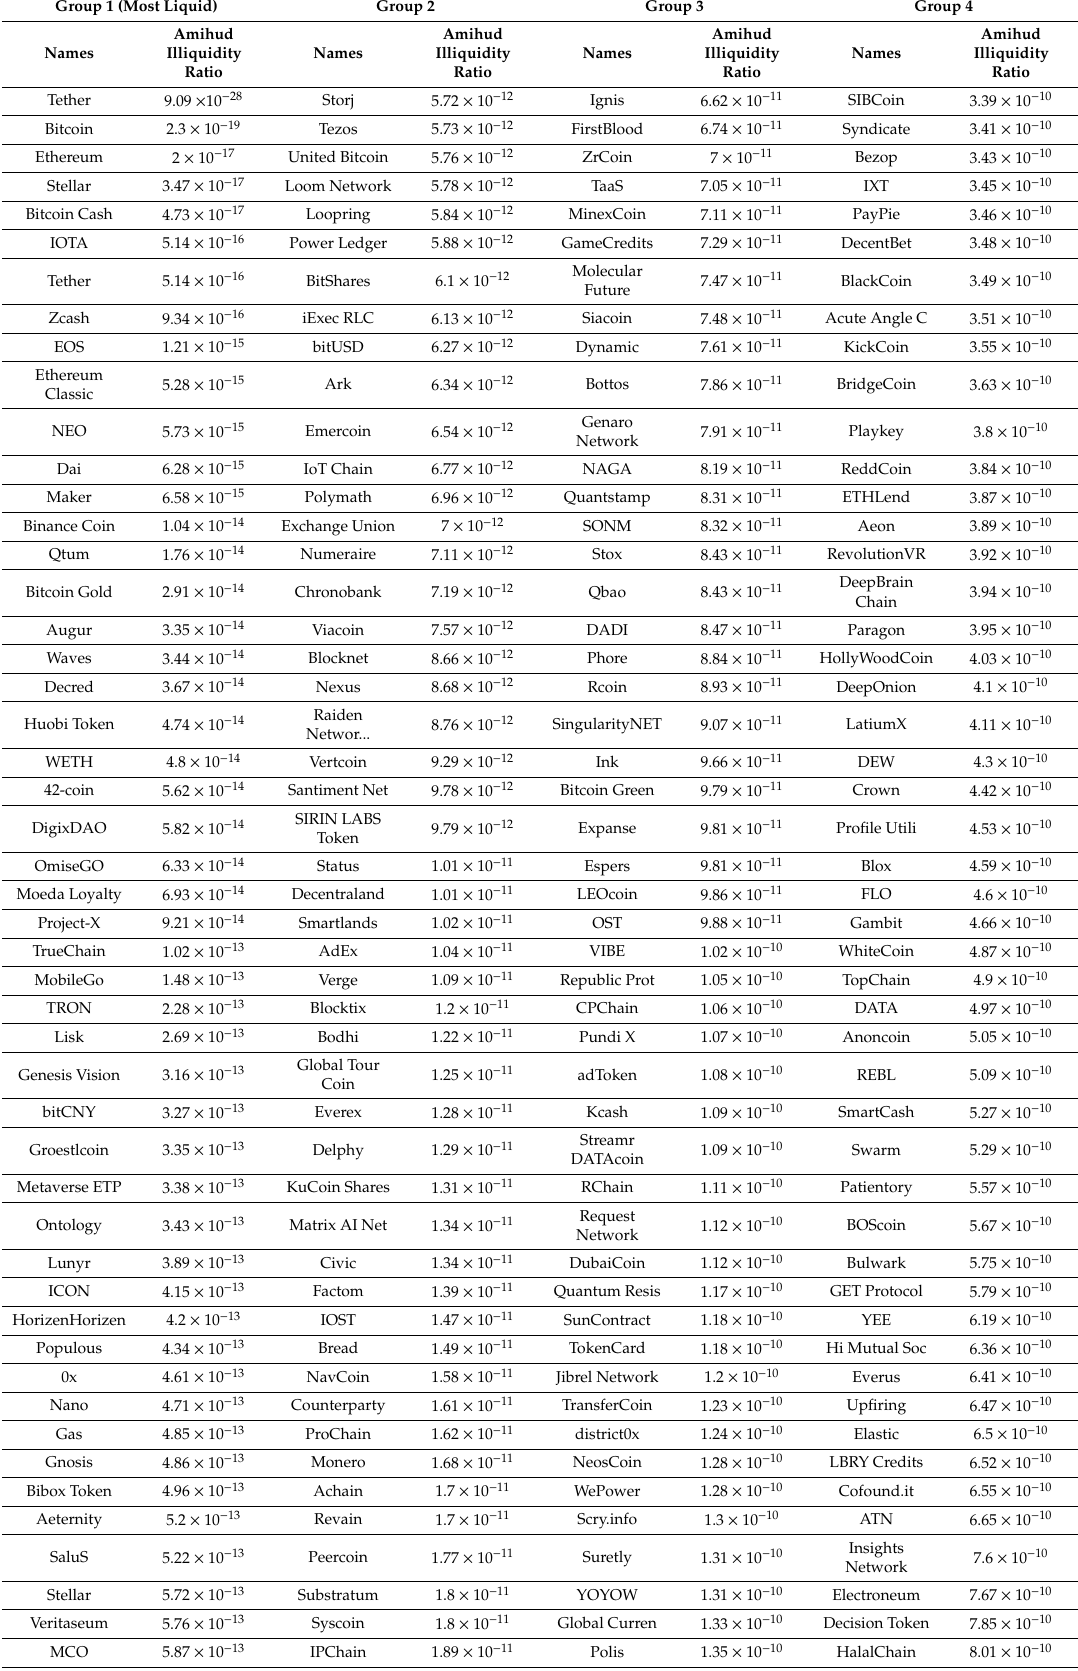
Table 1. Groups of most liquid